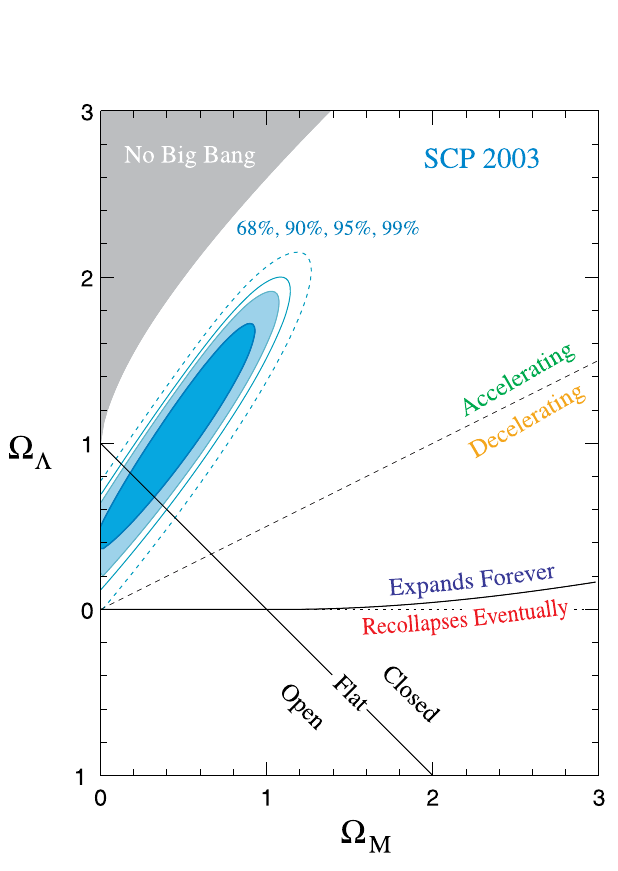
FIG. 27. Original figure from research group, showing the various scenarios relating to the relationship between the matter density ( Ω M ), and energy density ( Ω Λ ). Image credit: Knop et al.